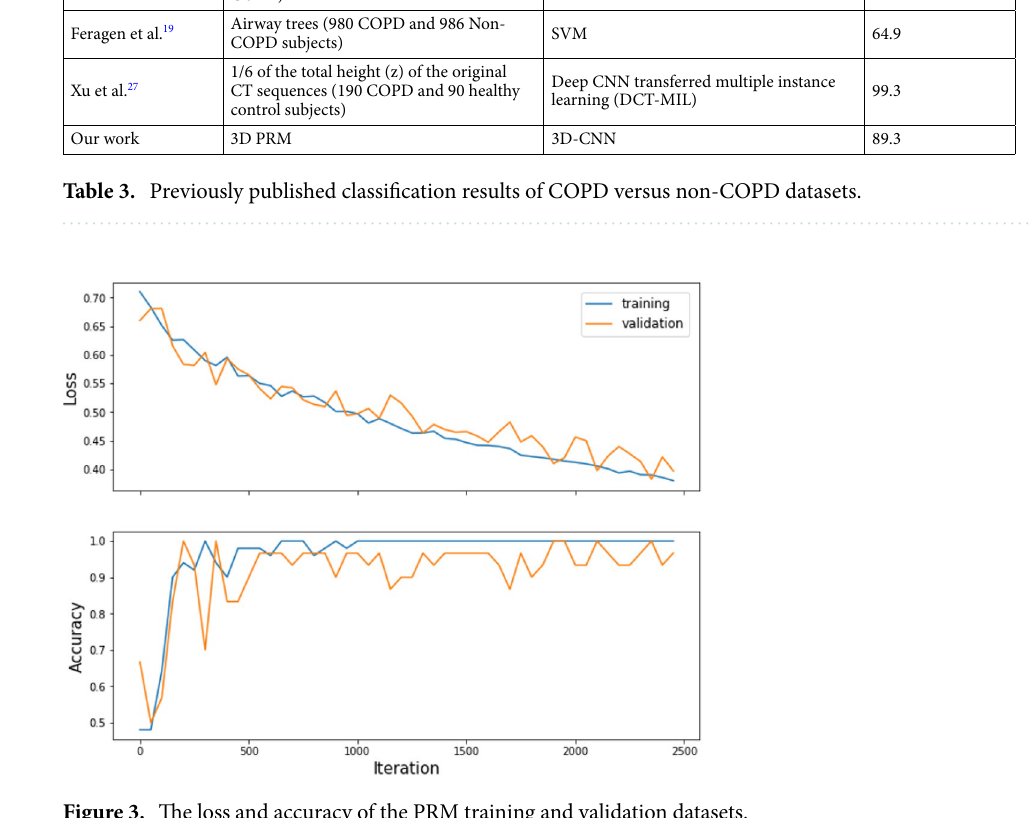
Figure 3. The loss and accuracy of the PRM training and validation datasets.